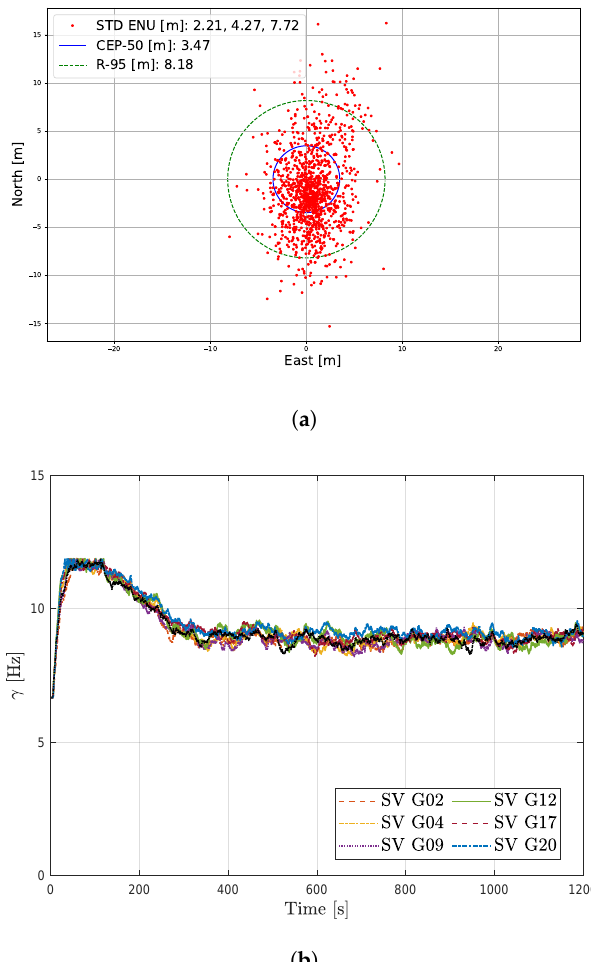
Figure 12. Results of LBCA-based FAP with unaided DLL at 34 dBHz in the static scenario. ( a ) Position point-cloud. ( b ) Loop-bandwidth variation of FAP